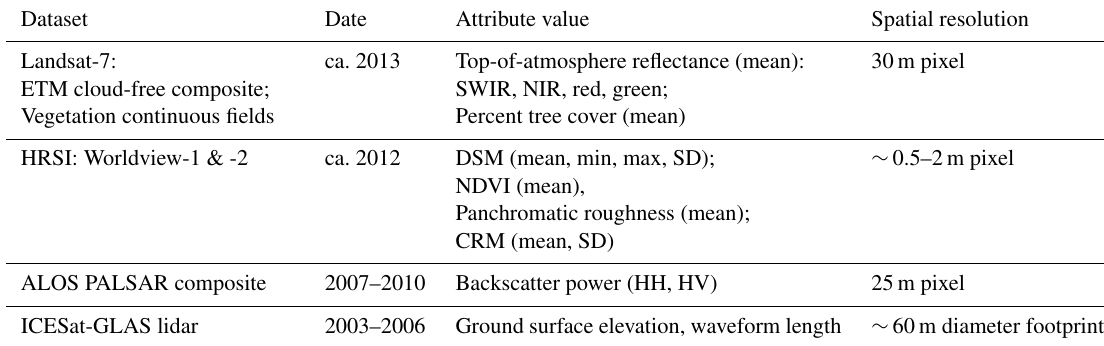
Table 1. Summary of spaceborne datasets used to delineate or attribute forest patches.